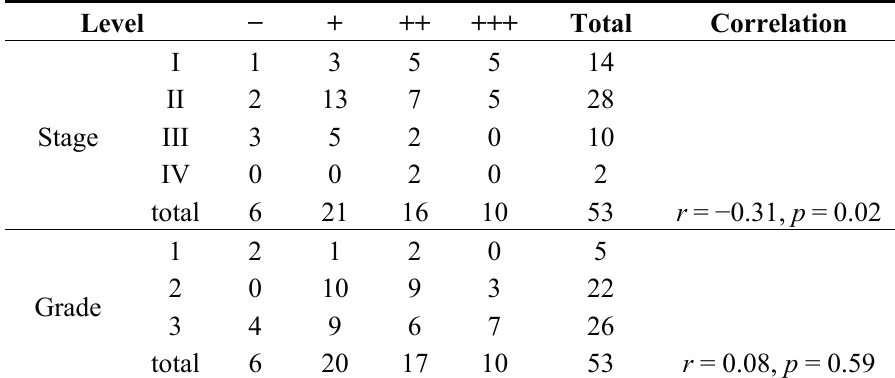
Table 2. Correlation of immunohistochemistry (IHC) scores with clinical stages and pathological grades. A negative correlation was observed between HE4 IHC score and clinical stage ( p = 0.02), but there was no correlation between HE4 IHC score and cancer grade ( p = 0.59) in the same TMA